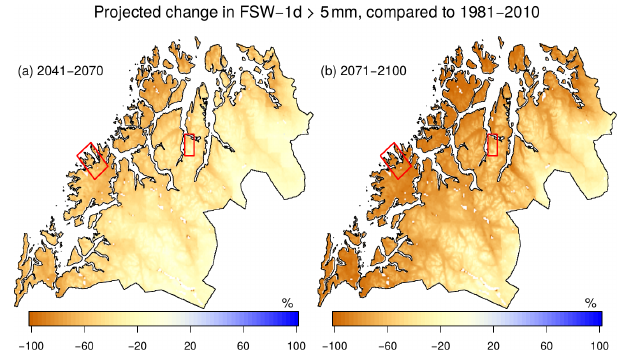
Figure 9. Projected change in maximum 1d snowfall during winter (October–April) between 1981–2010 and (a) the near future (2041– 2070) and between 1981–2010 and (b) the far future (2071–2100), based on maximum fresh snow water equivalent for 1d duration (WM-FSW-1d).